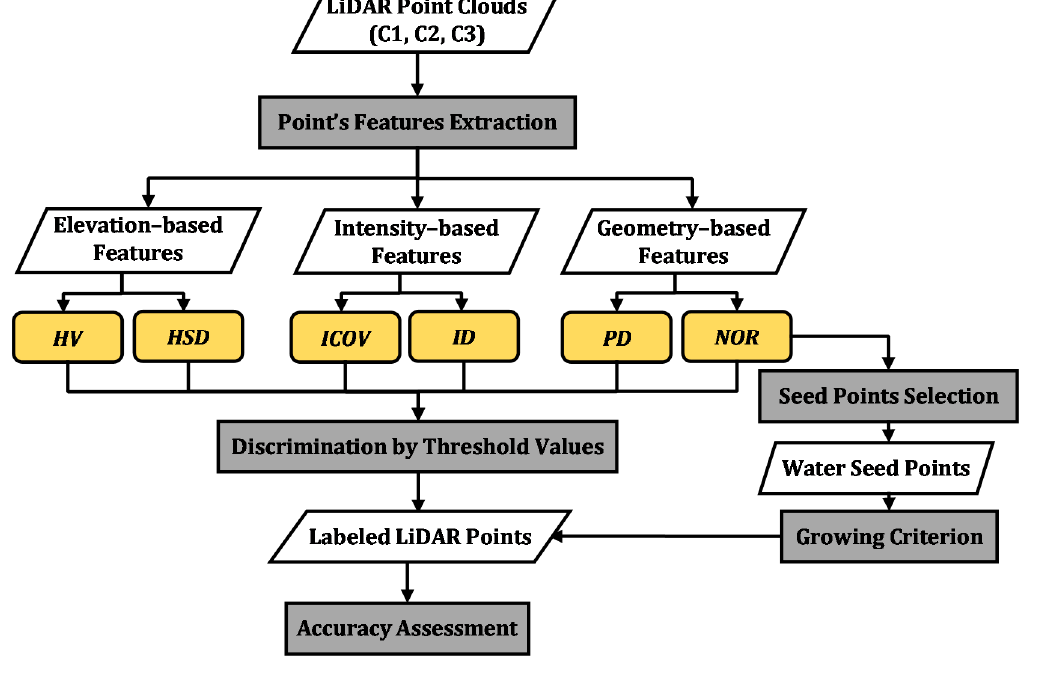
Figure 3. Workflow of land/water discrimination based on LiDAR point features and seeded region growing algorithm. HV : Height Variation; HSD : Height Standard Deviation; ICOV : Intensity Coefficient of Variation; ID : Intensity Density; PD : Point Density; and NOR : Number of Returns.